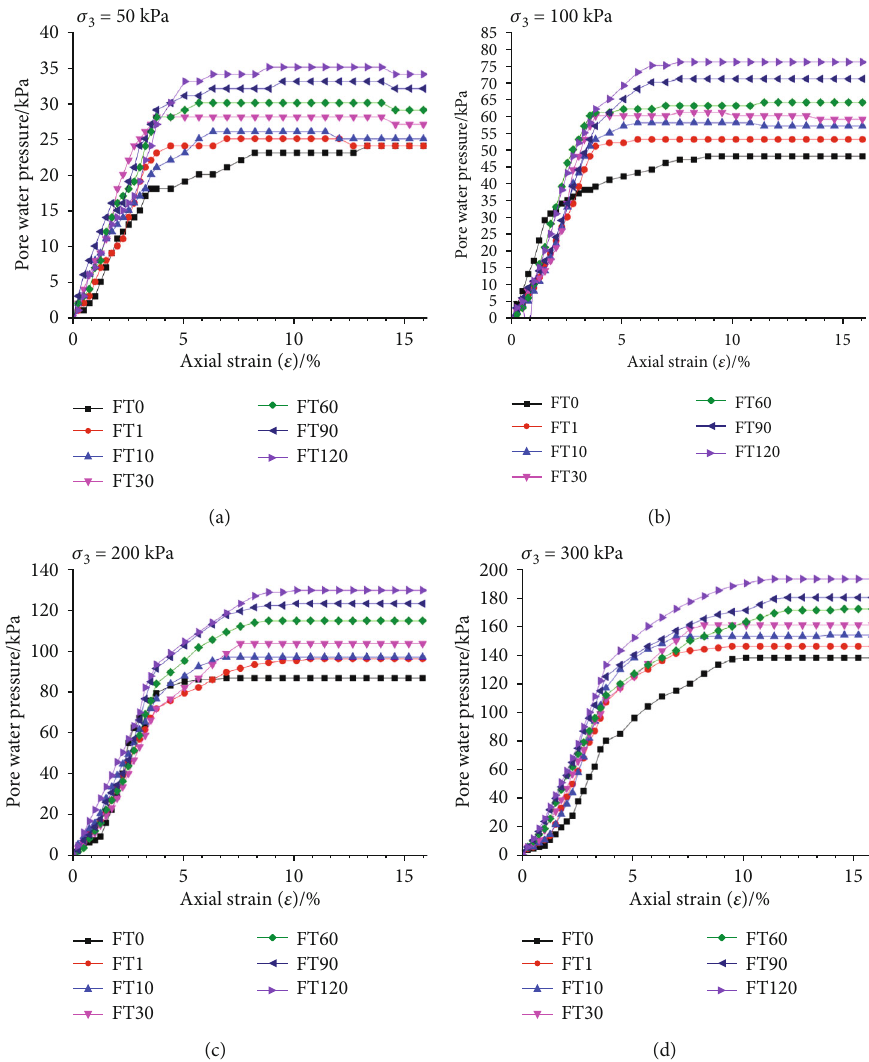
Figure 5: Pore water pressure-strain curves of specimens under di ff erent conditions.